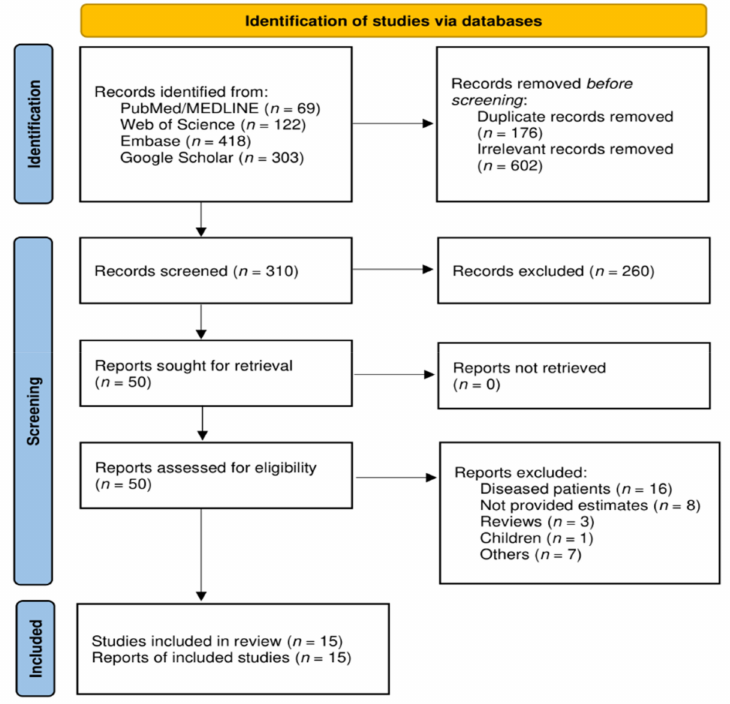
Figure 1. PRISMA Flow